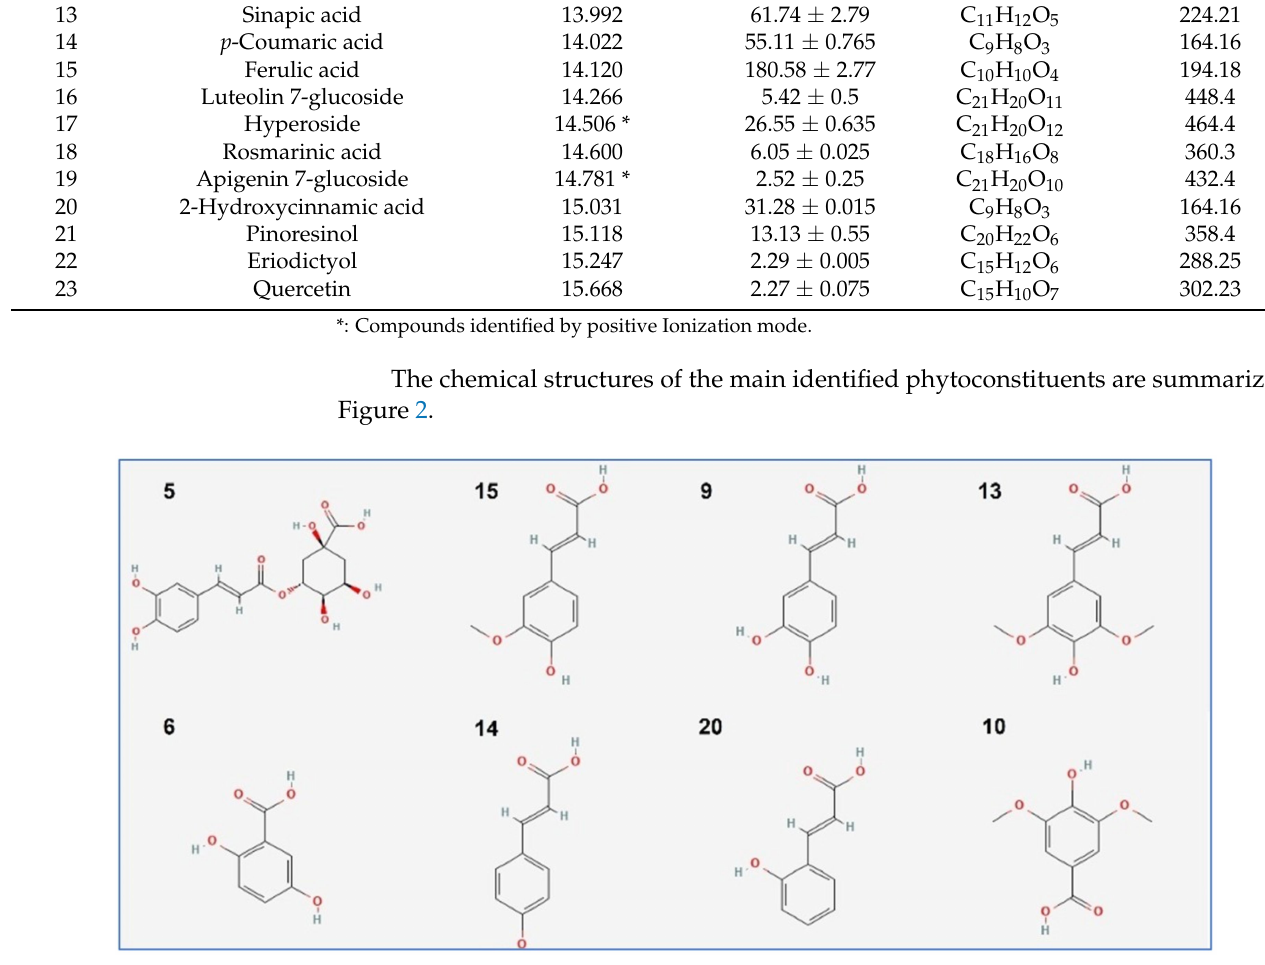
Figure 2. Chemical structure of the main compounds identified by ESI-MS/MS technique in the hydroalcoholic extract from D. flabellifolia aerial parts. Numbers are the same as listed in Table